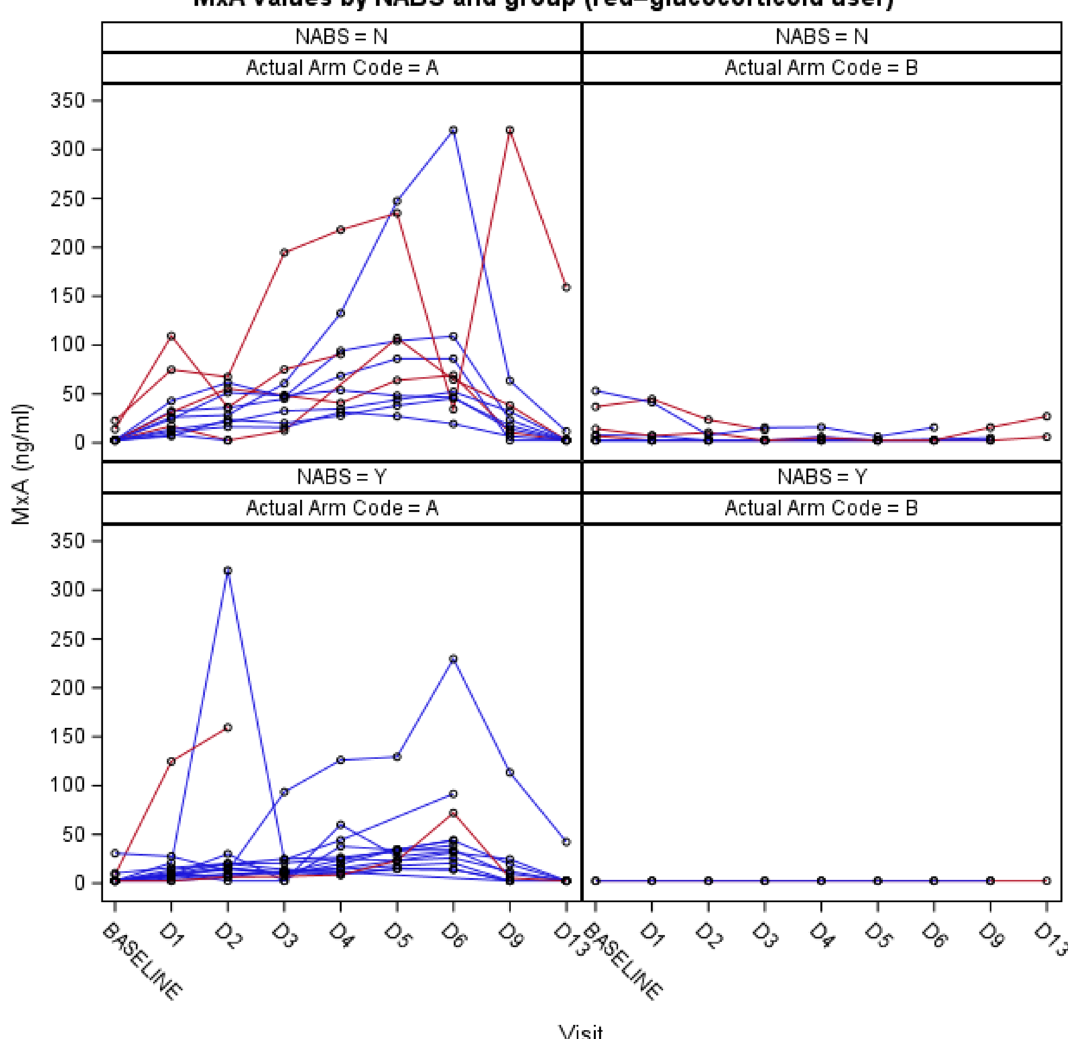
Figure 3. Myxovirus resistance protein A (MxA) levels in both treatment groups (A = IFN beta-1a group; B = placebo group) according to the presence of IFN beta-1a neutralizing antibodies (NABS) (Y = yes, elevated levels; N = elevated levels not